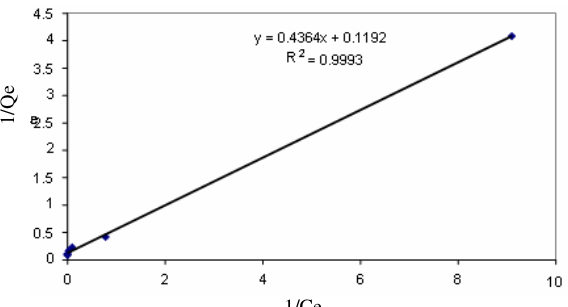
Figure7. Linearised Langmuir isotherm plot of cadmium in presence of copper